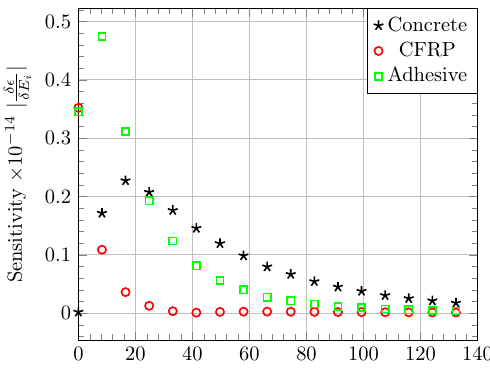
Figure 7. Sensitivity of the strain profile along the bonded joint to a 10% variation in the elastic moduli of the component materials, as evaluated using the elastic FE model.